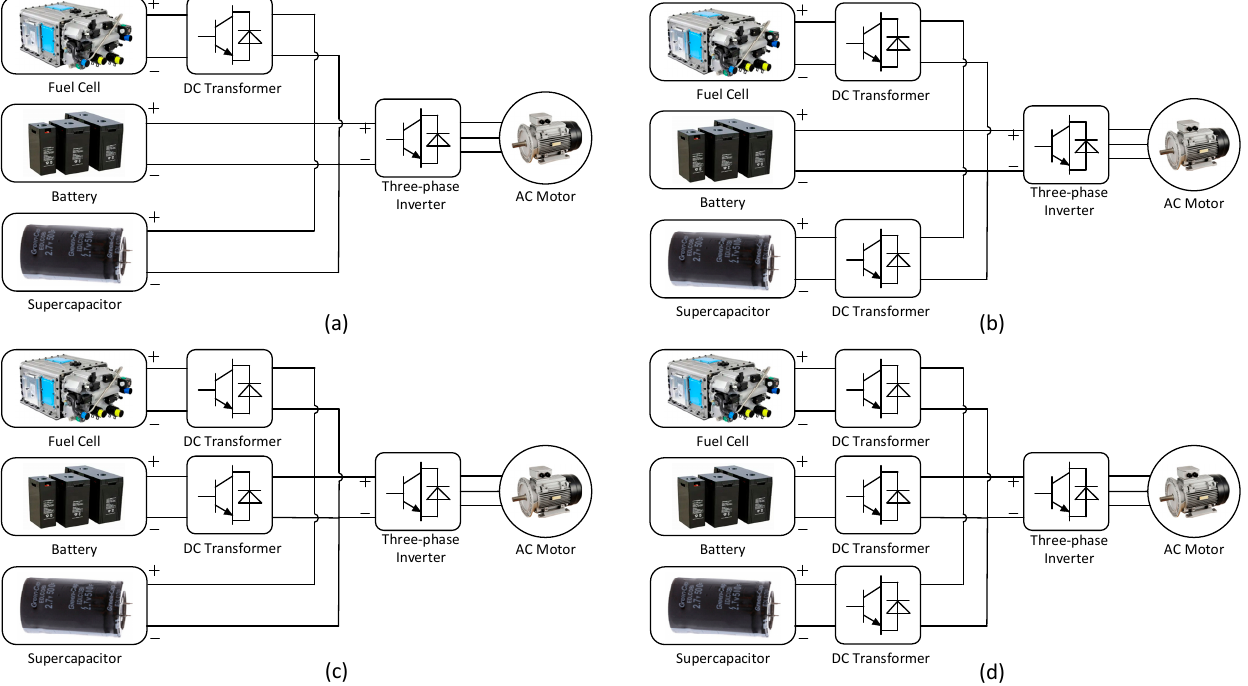
Figure 8. Topology of an FCEV (FC+B+SC). ( a ) Passive topology; ( b ) Semi-active topology; ( c ) Semi-active topology; ( d ) active topology.